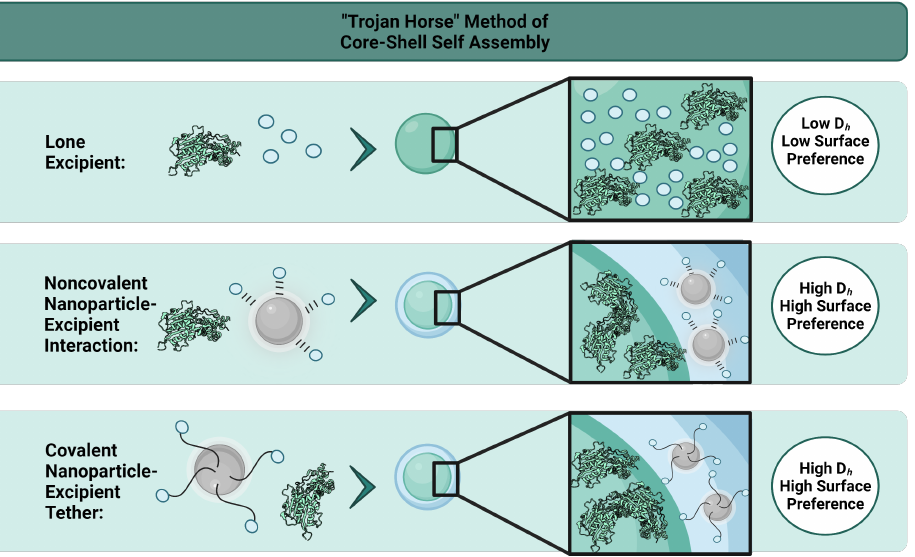
Figure 9. Proposed “Trojan” horse platform for controlled self assembly of core shell structures by single feed aqueous spray